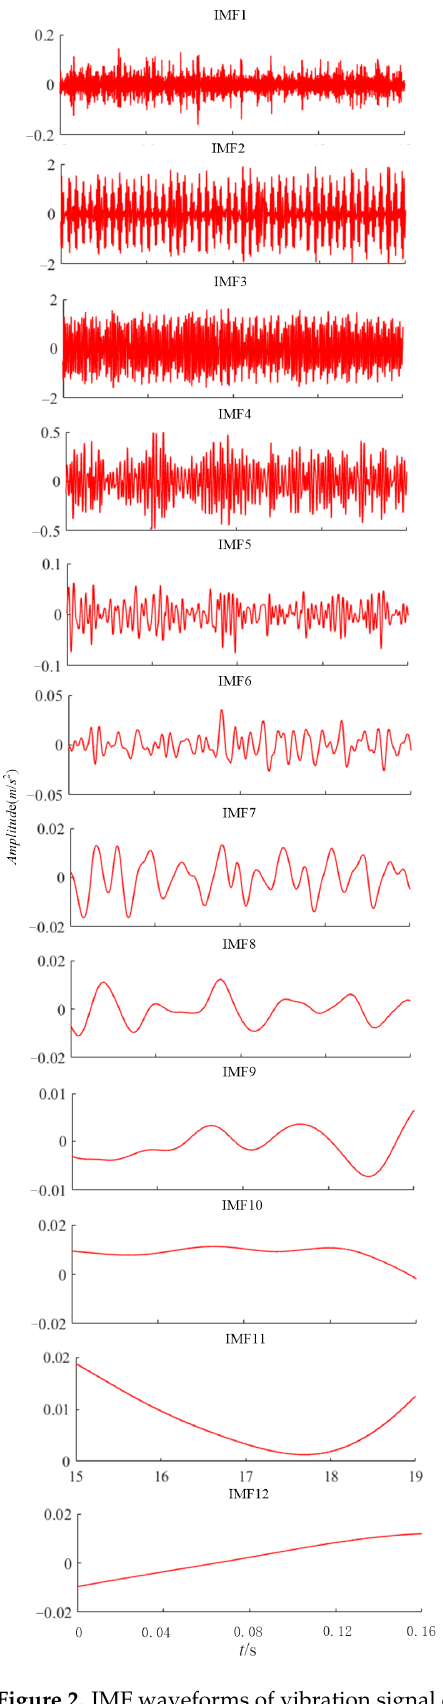
Figure 2. IMF waveforms of vibration signal of main pump in blade abnormal